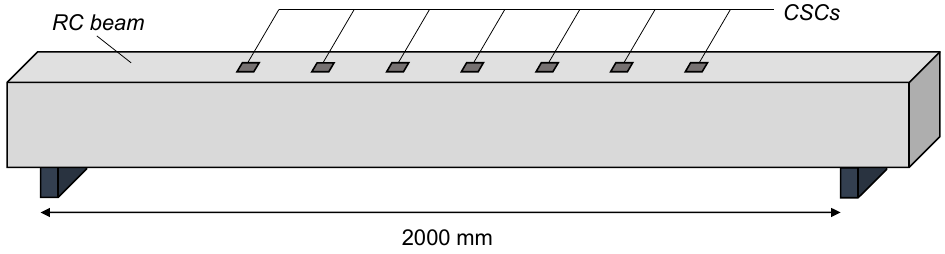
Figure 8. Distributed embedded sensors in a RC beam (adapted from [53]).